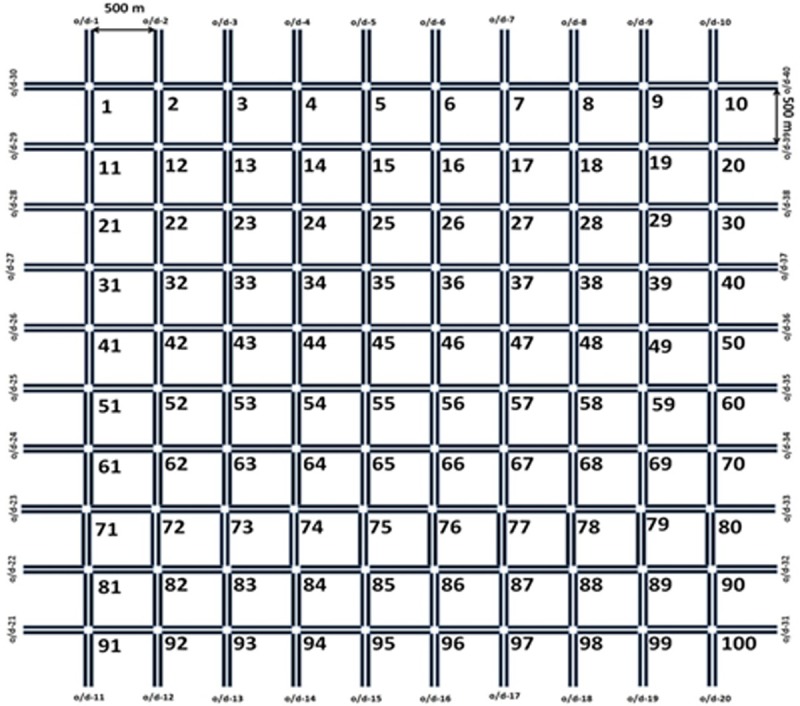
Grid network layout.